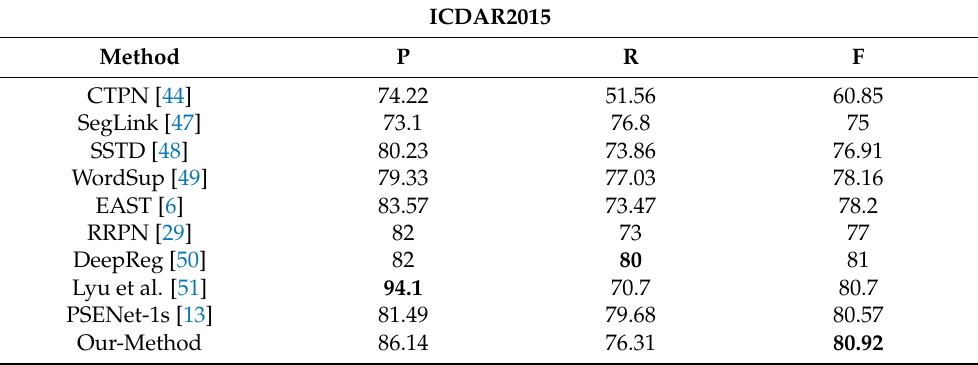
Table 4. The single-scale results on ICDAR2015. “P”, “R”, and “F” represent the precision, recall, and F-measure, respectively. The best results of all measures are